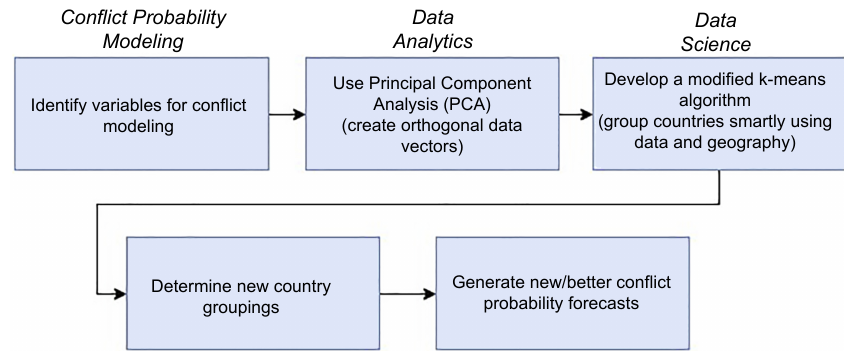
Figure 1. Overview of